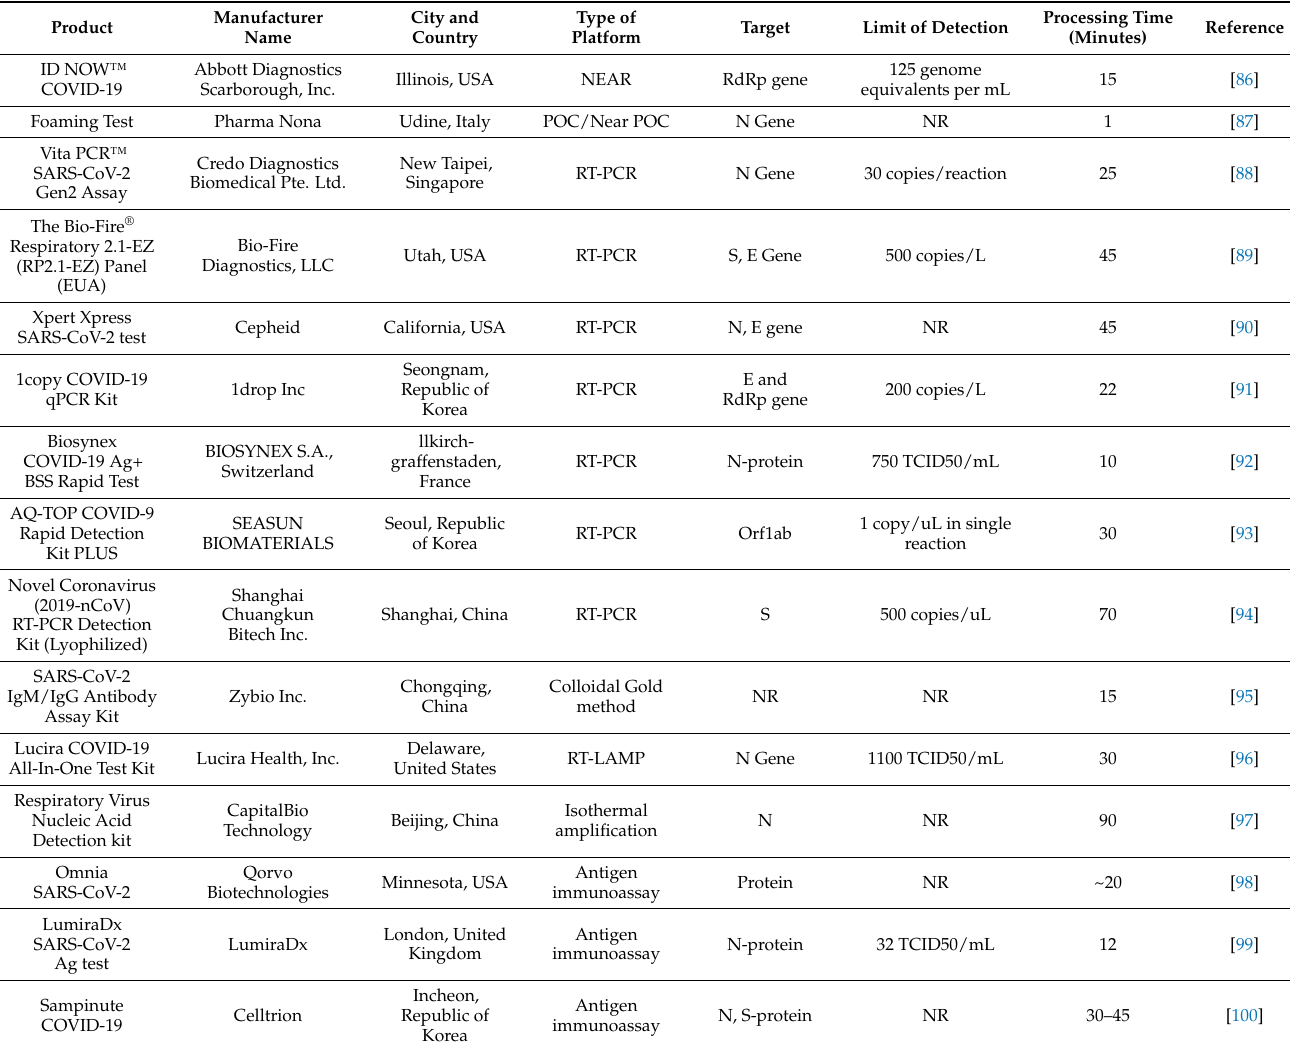
Table 4. Commercially available microfluidic platforms for